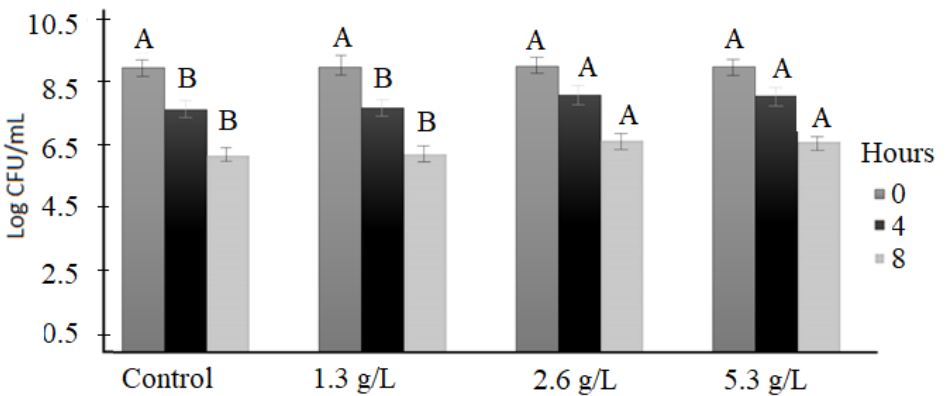
Figure 6. Log counts of L. bulgaricus to show bile tolerance as influenced by carao concentration and incubation time over 8 h. AB Values not containing a common letter over various concentrations for a given time are significantly ( p < 0.05) different.